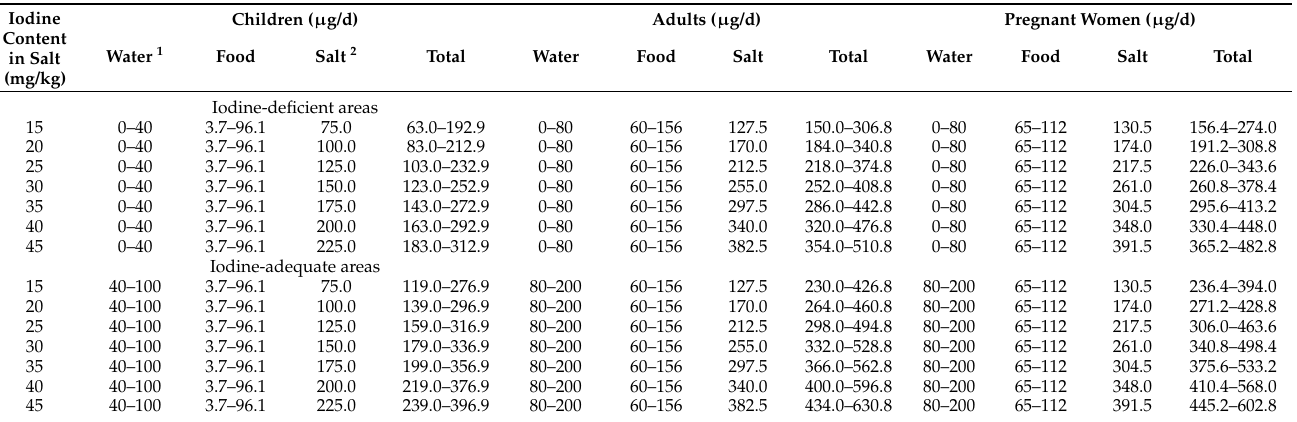
Table 2. Iodine intake of children, adults and pregnant women from different iodine sources in different water iodine